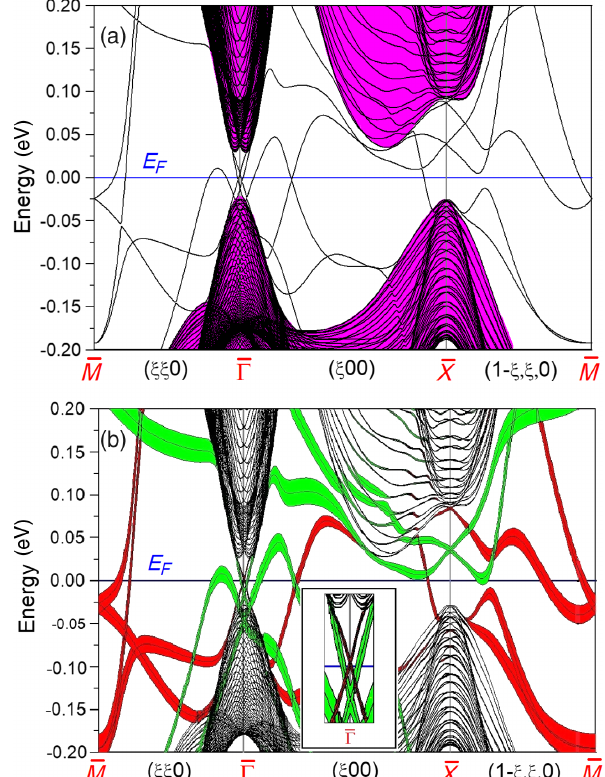
FIG. 4. (001) surface spectrum of UNiSn calculated along high- symmetry lines of the surface Brillouin zone, ¯ M ð 1 1 0 Þ , using the LDA þ DMFT method, assuming a 5 f 2 and 2 2 Γ 3 doublet as a ground state. (a) The projected bulk spectrum is shown by magenta. (b) Top (green) and bottom (red) surface states are fattened according to the partial character of the topmost (U-Sn) and bottommost (Ni) atomic plane of the slab. The inset provides a close view of the Dirac states near ¯ Γ the